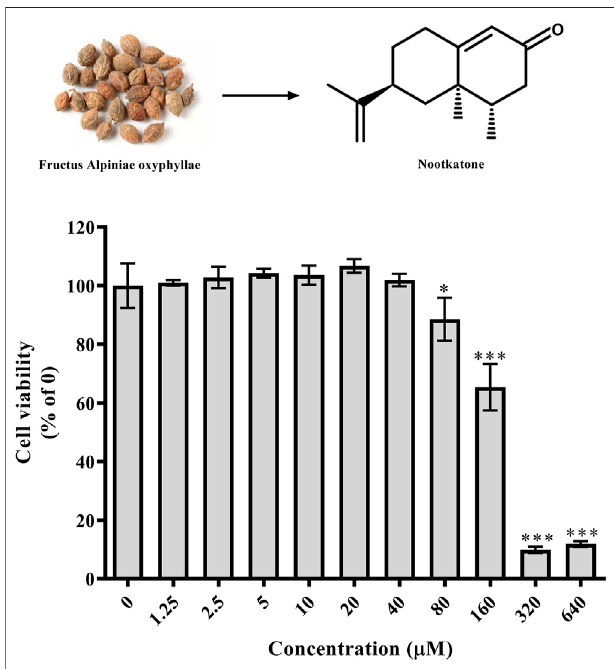
FIGURE 4 | Effects of Nok on cell viability in vitro . L02 cells were incubated with DMSO or Nok at the corresponding concentration for 24 h, and viability was tested by MTT staining. All values are presented as the means ± SD, * p < 0.05, ** p < 0.01, *** p < 0.001 vs. DMSO (0).